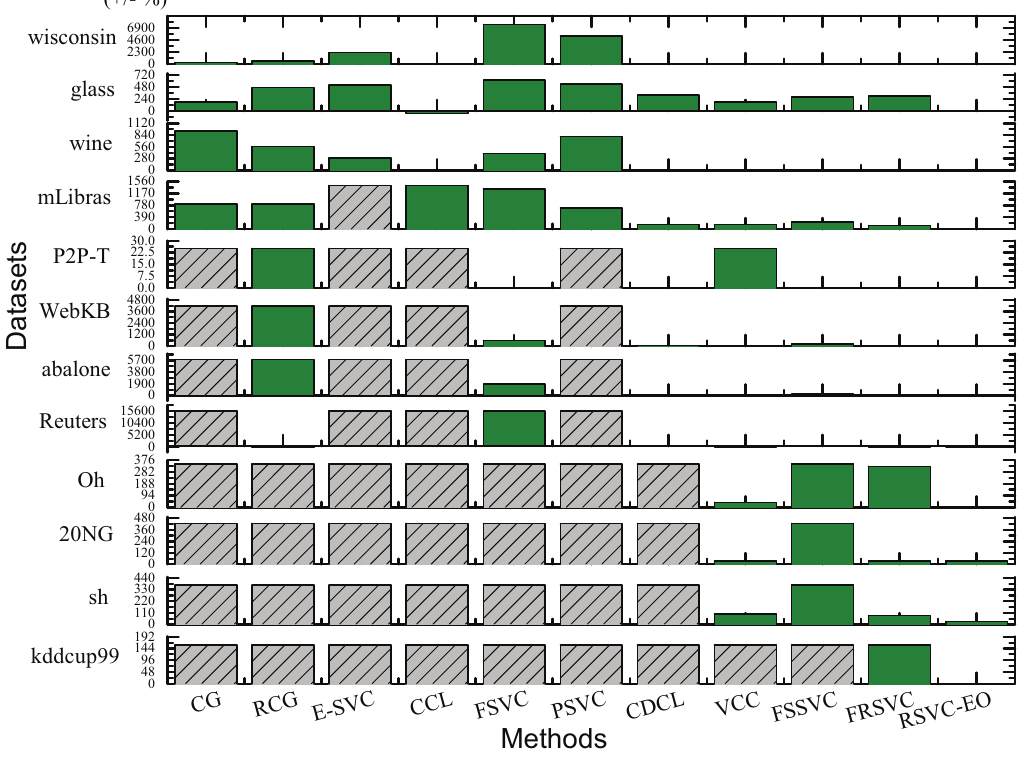
Figure 8. Difference between the captured cluster number (while each method achieve its best accuracy) and the real number of classes in terms of percentage (+/ − %). Table 5. ARIs achieved in ED for various scaling factor γ